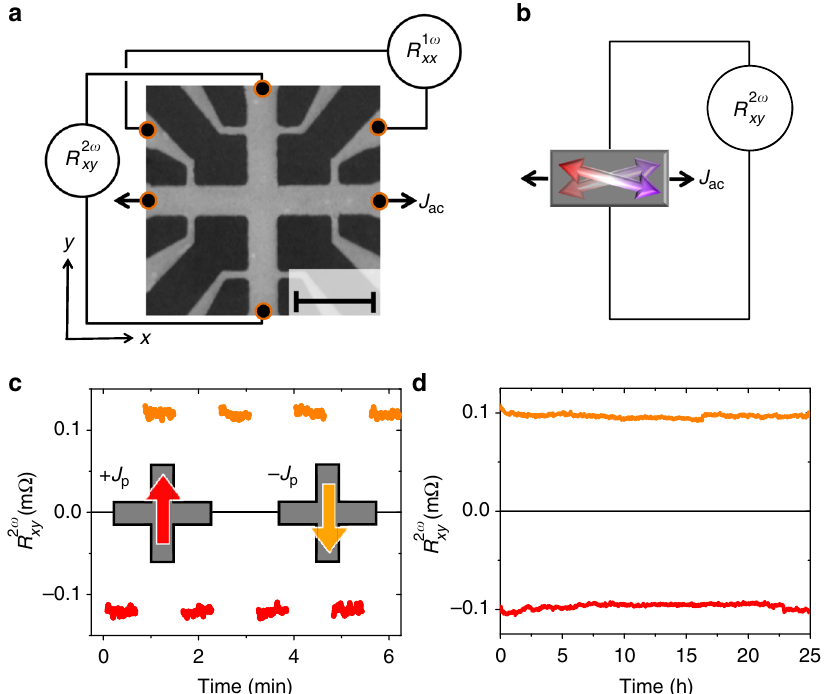
Fig. 2 Electrical detection of 180° reversal of the Néel order in CuMnAs. a Scanning electron micrograph of the cross-bar device with contacts allowing to measure longitudinal and transverse resistances along x and y axes. The added schematics correspond to the measurement set-up for the simultaneous detection of the transverse second-harmonics signal R 2 ω xy and the longitudinal fi rst-harmonics signal R 1 ω xx . The scale bar length corresponds to 10 μ m. b Schematics of measurement set-up with an alternating probing current J ac along x axis and second-harmonic voltage detected along y axis, giving R 2 ω xy . Double-arrows illustrate a microscopic mechanism in which J ac generates alternating de fl ections of the antiferromagnetic moments. c 20ms long pulses of (cid:2) 10 7 Acm − 2 in CuMnAs) along the ± y direction (red/yellow arrows) are applied to set the Néel vector along the ± x axis. the writing current J p = 11mA ( j p (cid:2) 10 6 Acm − 2 ) applied along the x axis. d Same as c for one Second-harmonic transverse resistance R 2 ω xy is measured with a probing current J ac = 2mA ( j ac writing pulse along + y axis and one subsequent pulse along − y axis and 25 h measurement of the stability of the second-harmonic probing